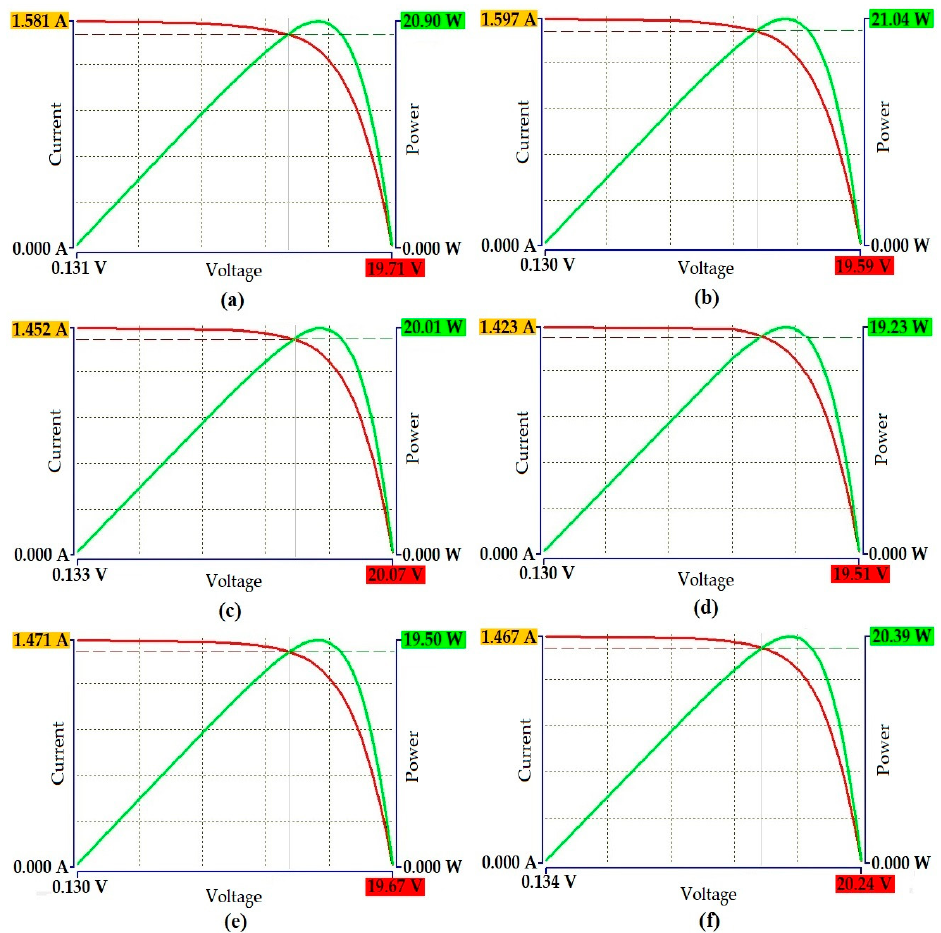
Figure 3. I-V curves generated by developed module: ( a ) 20.90 W achievement; ( b ) 21.04 W achievement; ( c )20.01Wachievement; ( d )19.23Wachievement; ( e )19.50Wachievement; and( f